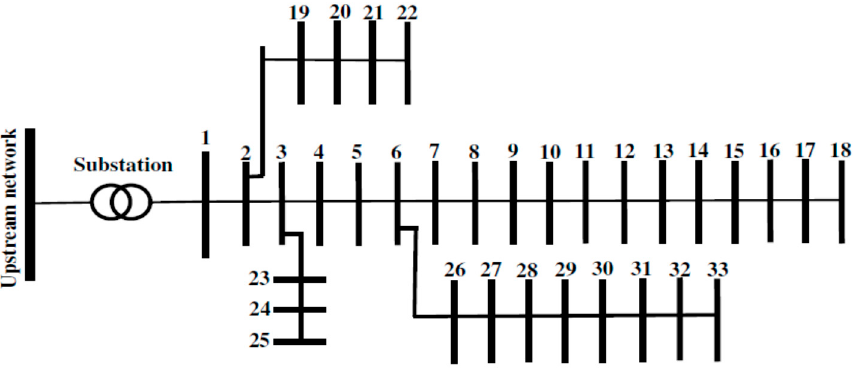
Figure 3. The 33-bus distribution Figure 3 . The 33-bus distribution system.